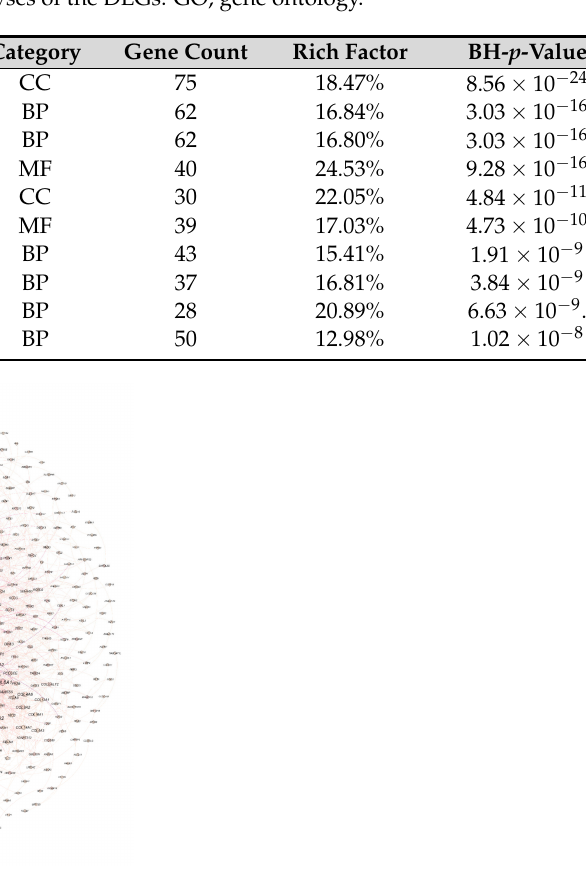
Figure 4. The PPI network of the DEGs. The circle size and color are set for degree and betweenness scores, respectively. The larger the circles, the greater the degree score. In addition, richly colored circles have a higher betweenness score. PPI network, protein–protein interaction network; DEGs, differentially expressed genes.